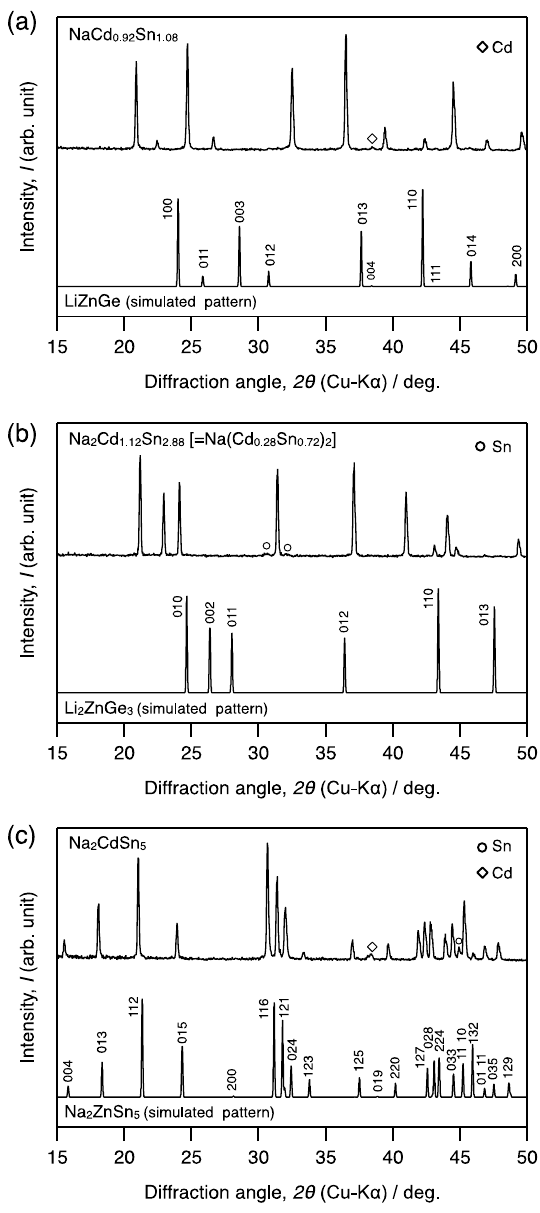
Figure 1. Powder XRD patterns of the polycrystalline samples prepared from starting materials with molar ratios of Na:Cd:Sn = 1:0.92:1.08 ( a ), 2:1.12:2.88 ( b ), and 2:1:5 ( c ) (upper patterns), and the simulated XRD patterns of isostructural compounds, LiZnGe ( a ), Li 2 ZnGe 3 ( b ), and tI -Na 2 ZnSn 5 ( c ) (lower patterns).